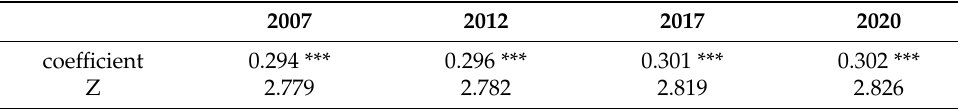
Table 3. Global Moran’s I index of forest carbon